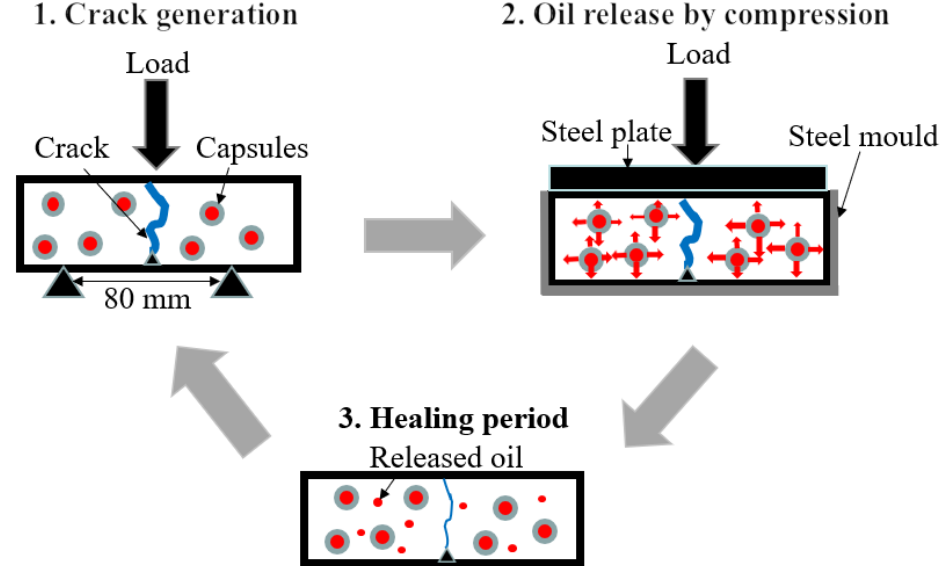
Figure 3. Fracture-cyclic compression loading – healing test procedure.